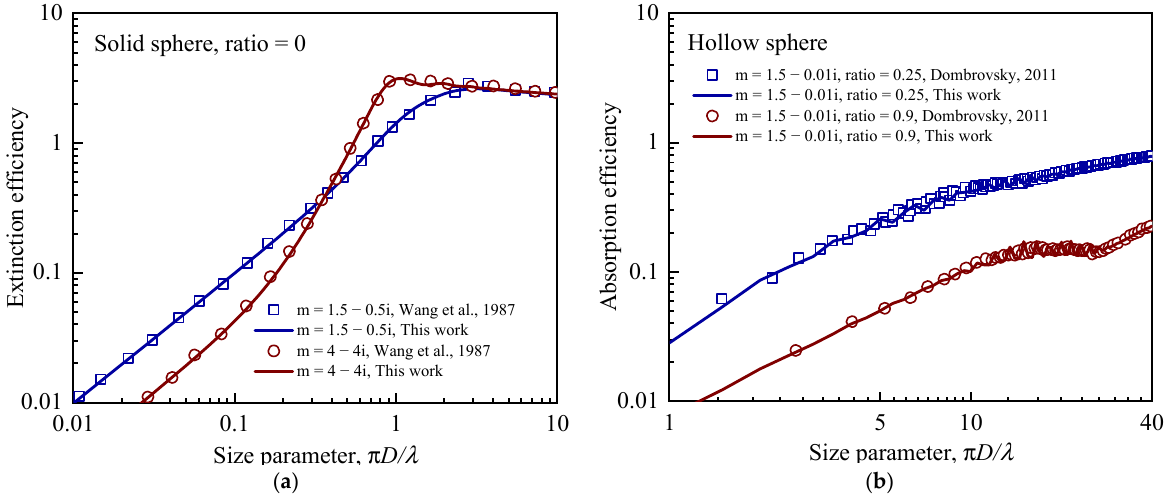
Figure 2. Comparison of radiative properties of solid and hollow spheres with those from the literature [21,22]. ( a ) Extinction efficiency of a solid sphere vs. size parameter, and ( b ) Absorption efficiency of a hollow sphere vs. size parameter. Adapted with permission from Ref. [21], 1983, Elsevier, and Ref. [22], 2011, Begell House,